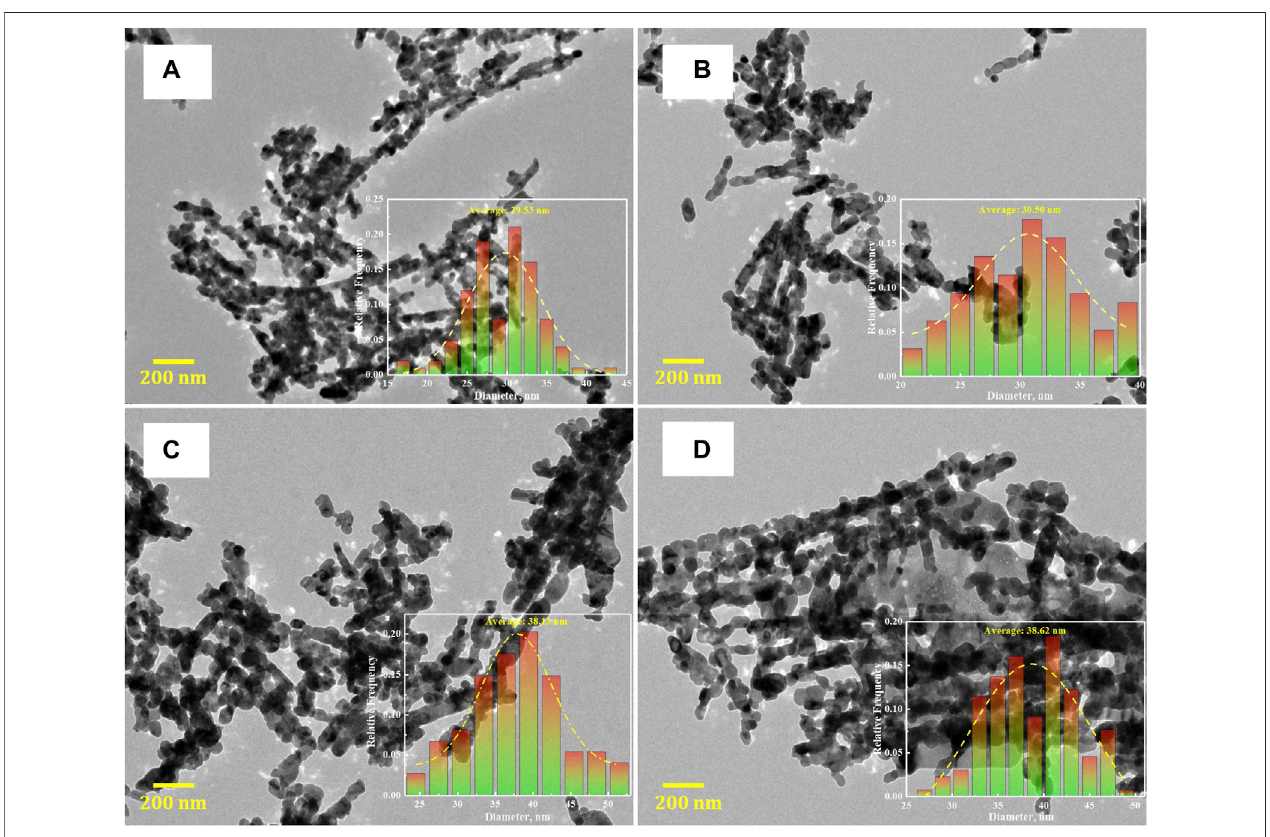
FIGURE 2 | HRTEM images of the CuO catalysts synthesized with different templates. (A) CuO-PVP; (B) CuO-SDS; (C) CuO-F127; (D) CuO-P123.